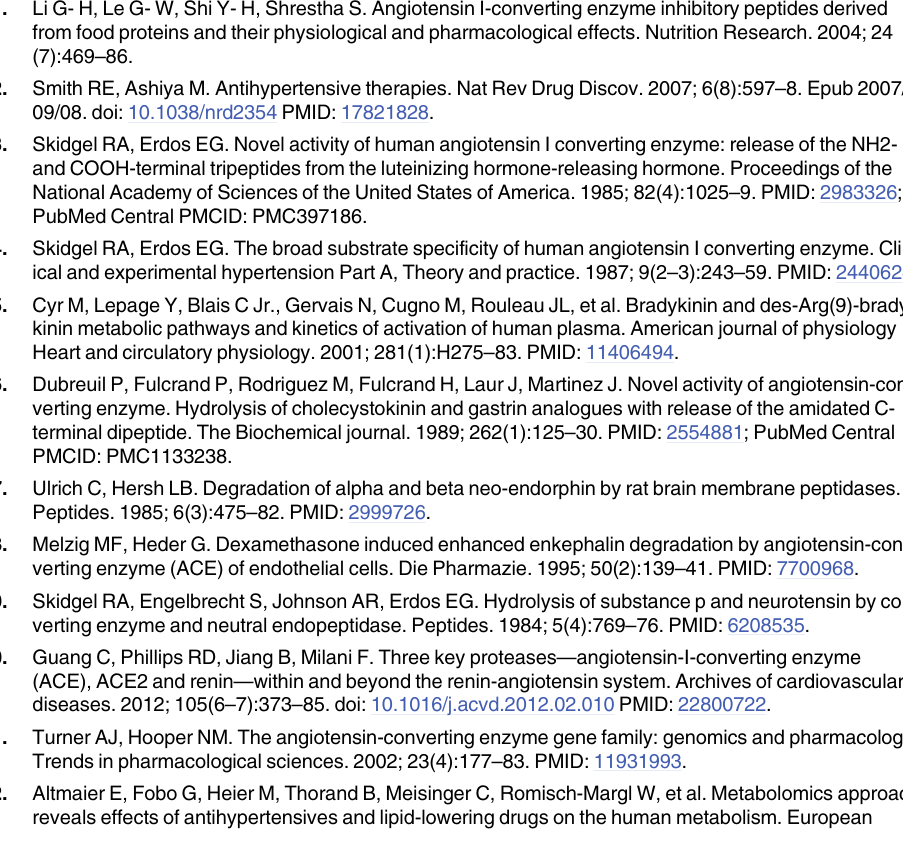
S2 Table. Metabolites measured in KORA F4. S3 Table. Results for all analyzed ACE SNPs in